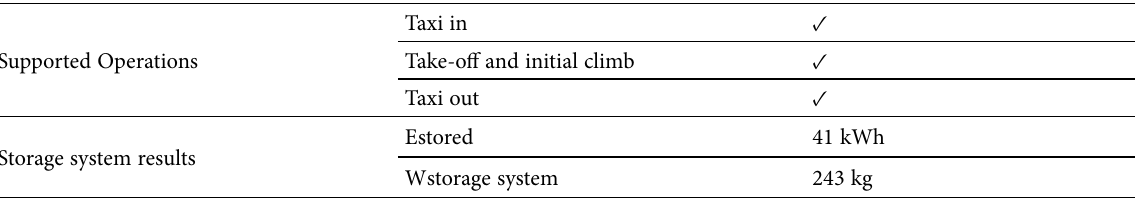
Table 7. Storage system sizing to support Green Taxi and over-boost